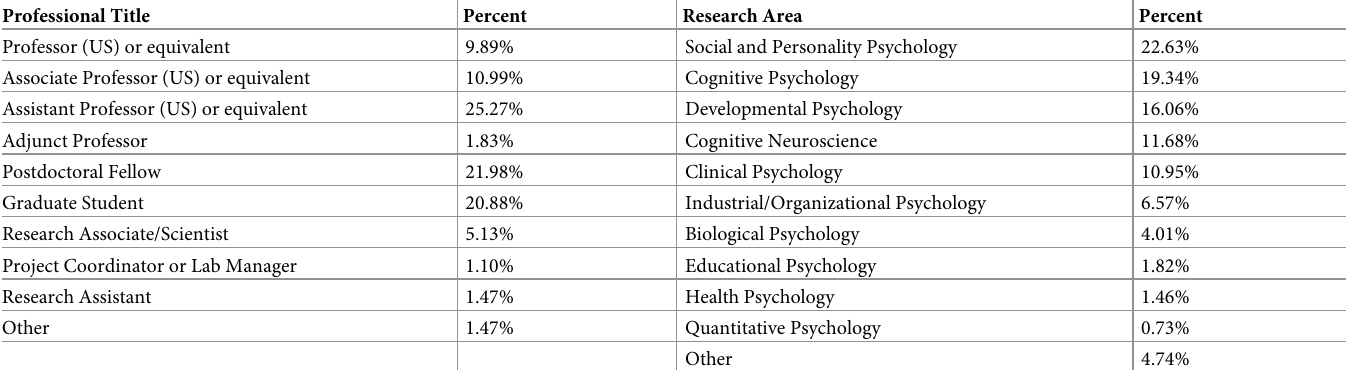
Table 1. Participant characteristics. Participants represented a range of psychology subdomains and included a mix of trainees (graduate students, postdoctoral fellows) and individuals with faculty positions (assistant, associate, and full